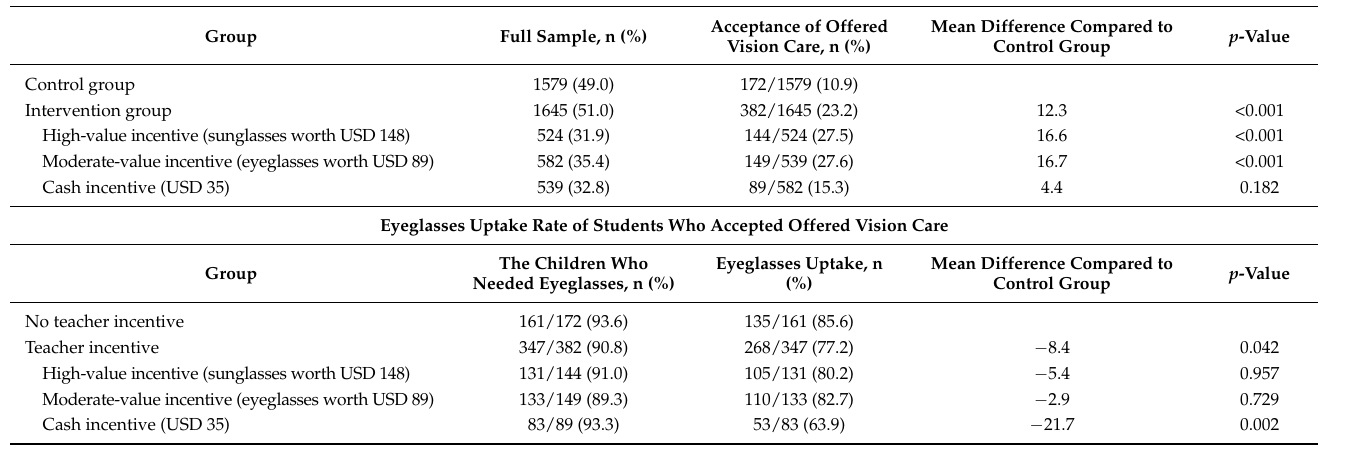
Table 2. Descriptive statistical analysis of the impact of providing teacher incentives on students’ acceptance of offered vision care and on the eyeglasses uptake rate.